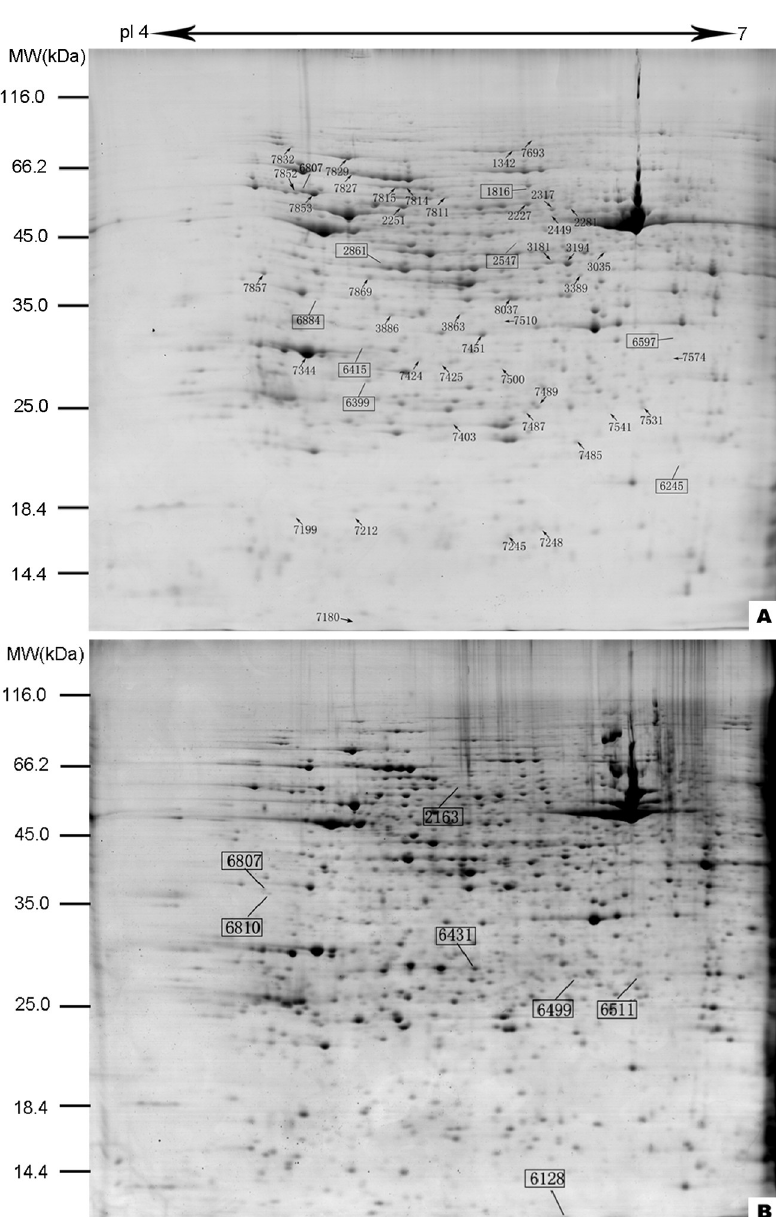
Fig 4. Representative 2-DE images of proteins from C . thalictroides gametophytes. (A) Protein gel from hermaphroditic gametophytes; (B) protein gel from male gametophytes. Fifty-seven differentially abundant proteins are marked with numbers on the gels. Squares refer to specific proteins. Molecular weight (MW) in kDa and pI of proteins are indicated on the left and top of the gels, respectively. Detailed information can be found in Table 1.